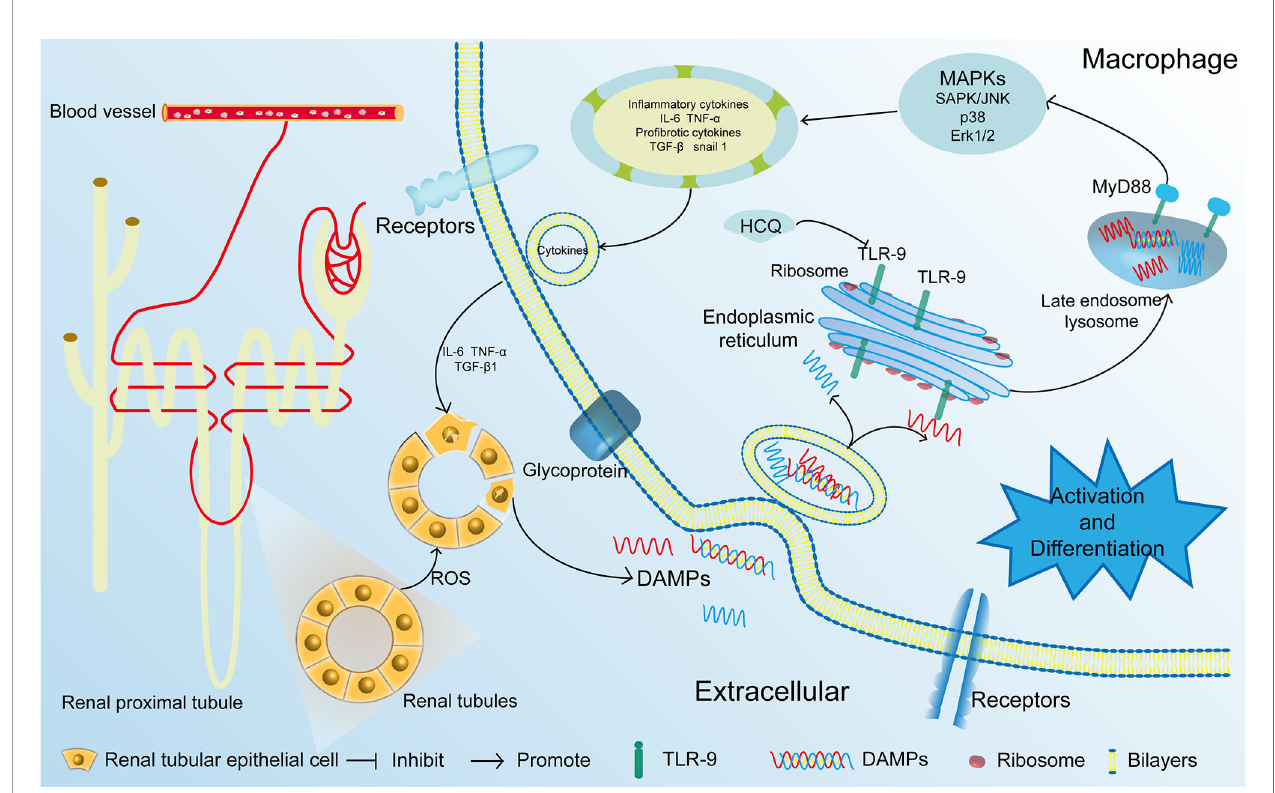
FIGURE 8 | Proposed mechanisms of HCQ function in renal fi brosis following IRI. After being exposed to ischemia and reperfusion, RTECs were damaged. DAMPs that were released from the damaged RTECs fl owed into blood vessels and activated monocytes. DAMPs also activated the TLR-9/MyD88 signal pathway, thereby activating MAPKs. In fl ammatory and pro fi brotic cytokines including IL-6, TNF a , TGF- b were synthesized and released, resulting in the aggravation damage and fi brosis of kidney. RTECs, renal tubular epithelial cells; TLR-9, toll-like receptor-9; IRI, ischemia-reperfusion injury; DAMP, damage-associated molecular